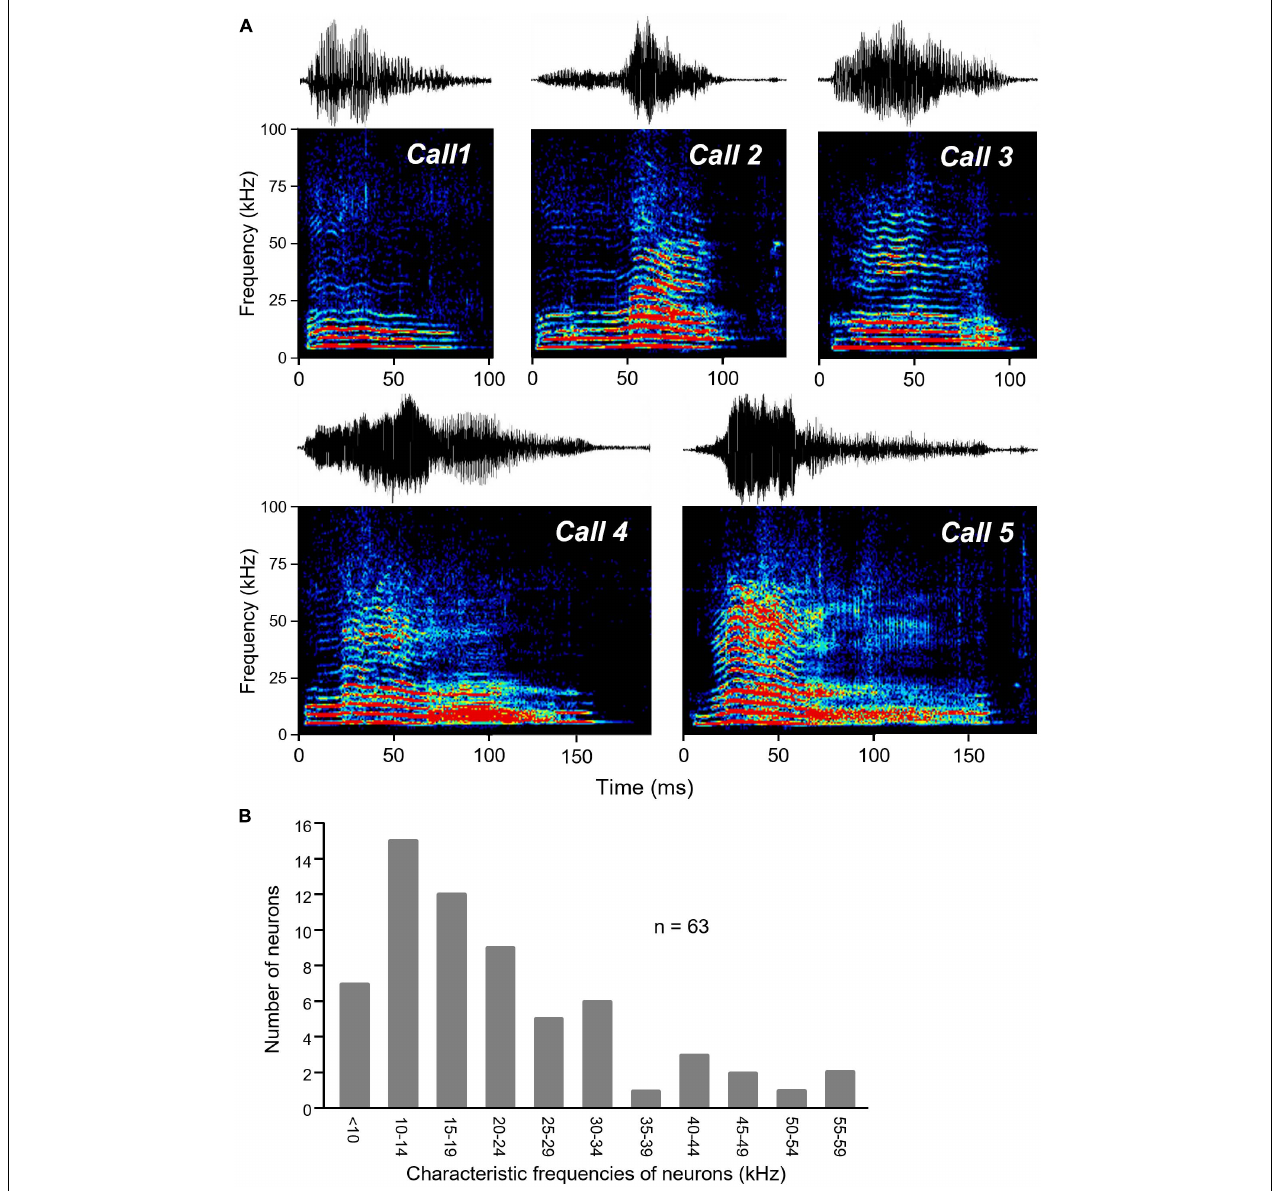
FIGURE 1 | BBVs played to mice. (A) Oscillograms (top part of each panel) and spectrograms (lower part of each panel) of the five recorded BBVs used as stimuli for IC neurons. Calls varied in amplitude envelope as well as in duration, spectrotemporal structure, and whether deterministic chaos was present (in the latter portions of calls 3, 4, and 5). Colors represent relative intensity of specific call components. (B) Histogram of the characteristic frequencies (CF) of neurons responding to BBVs, which also responded to tones for estimation of CF.